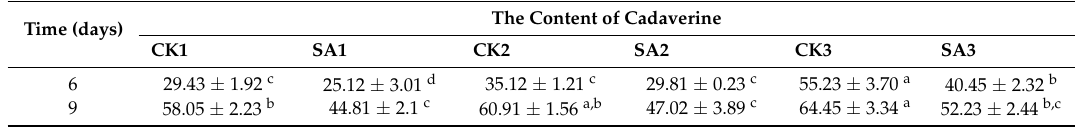
Table 5. Effect of CFS from A. sobria on cadaverine production of Pacific white shrimp ( L. vannamei ) during different cold chain logistics.